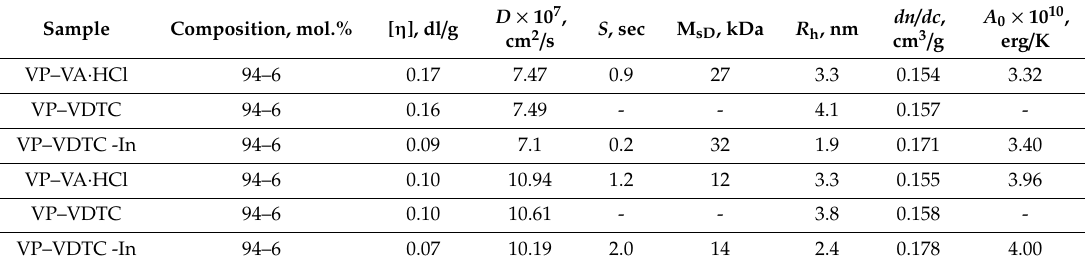
Table 1. Molecular characteristics of VP–VDTC copolymers and their MPC with indium in 0.2 M NaCl.